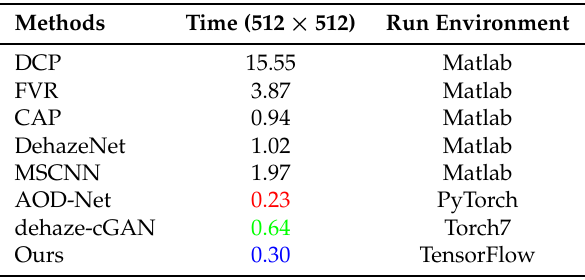
Table 5. Average run time (in seconds) on synthetic data. The top three results are highlighted in red, blue, and green font,